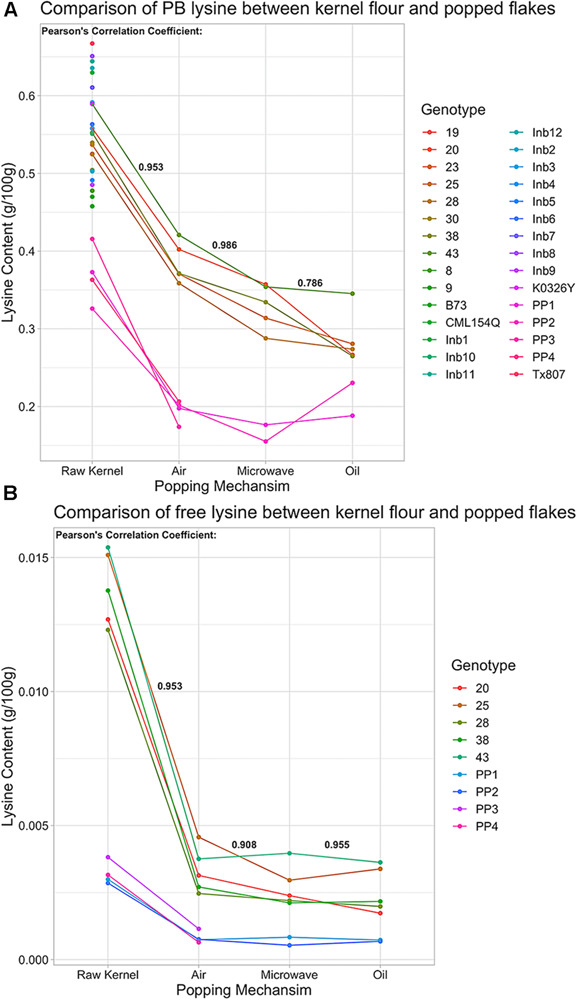
Protein-bound and free lysine content of QPP Hybrids, Inbreds, QPM, and Popcorn Germplasm in raw kernel and popped flakes. (A) Protein-bound lysine content (g/100 g) in various germplasm samples under air, microwave, or oil popping conditions compared to raw kernel powder. Points along vertical “Raw Kernel” axis are lysine levels from germplasm that was not popped. (B) Free lysine (g/100 g) in multiple germplasm samples under air, microwave, or oil popping conditions compared to raw kernel powder. Correlation Coefficients between protein-bound and free lysine levels in raw kernel and air popped flakes, air popped flakes and microwaved flakes, and microwaved flakes and oil popped flakes were calculated and are in respective positions in bold. Genotypes with solely a numbered label signify QPP hybrids, QPP Inbreds are named “Inb” preceding inbred number, and “PP1” – “PP4” represent “Popcorn Parent 1–4,” respectively.